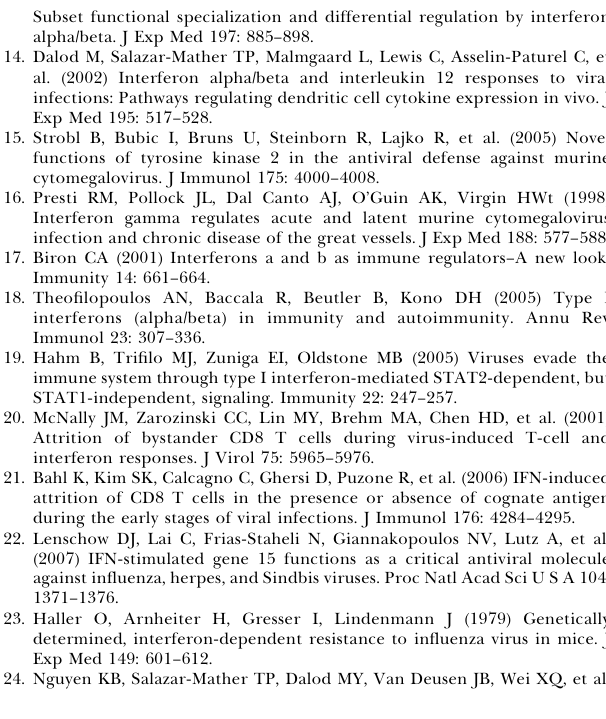
Figure S1. Klra8 Mice but Not BALB/c Animals Show a Dramatic Expansion of NK Cells during MCMV Infection and Control Early Viral Replication Efficiently through NK Cell Activity Found at doi:10.1371/journal.ppat.0030123.sg001 (437 KB TIF).